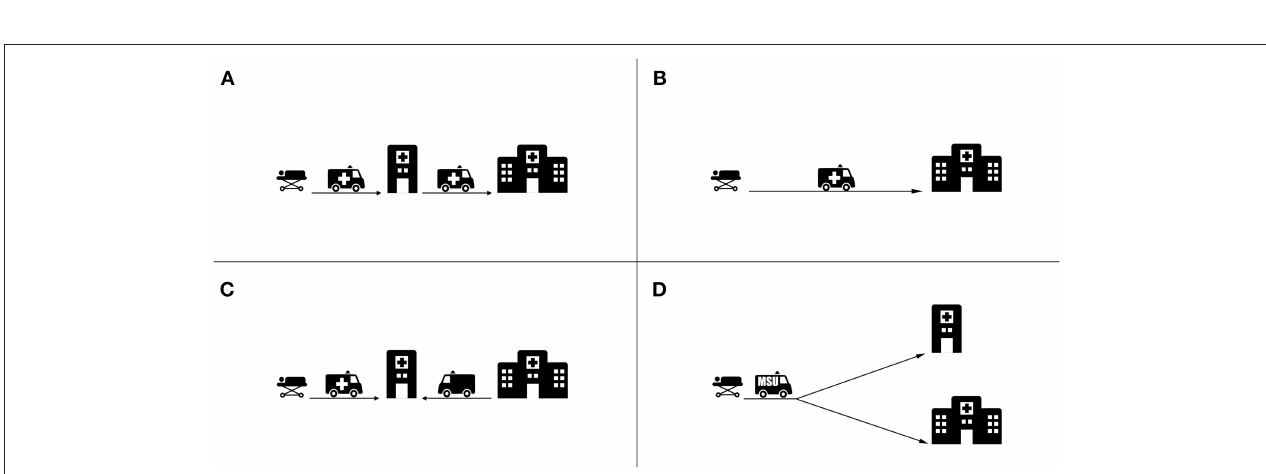
FIGURE 2 | Main transport strategies for acute stroke patients. (A) Drip and Ship strategy whereby the patient is transported from the emergency site to a PSC for thrombolysis and then further transported to a CSC for thrombectomy. (B) Mothership strategy whereby the patients is transported directly to the CSC, bypassing the PSC. (C) Specialist Rendezvous strategy (sometimes called “flying” doctor) whereby the patient arriving at the PSC is met by an interventionalist from a CSC. (D) MSU Strategy whereby triage decisions are made at the emergency site and the patient is transported based on the diagnosis to a PSC or CSC where